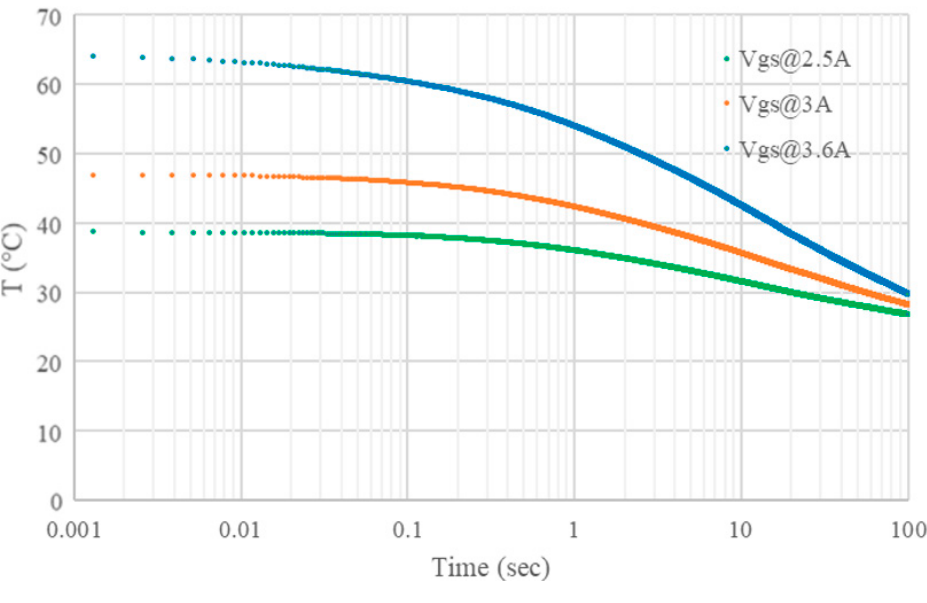
Figure 14. Cooling curves of V gs. Table 4. Values of Zth obtained using V gs TSEP.